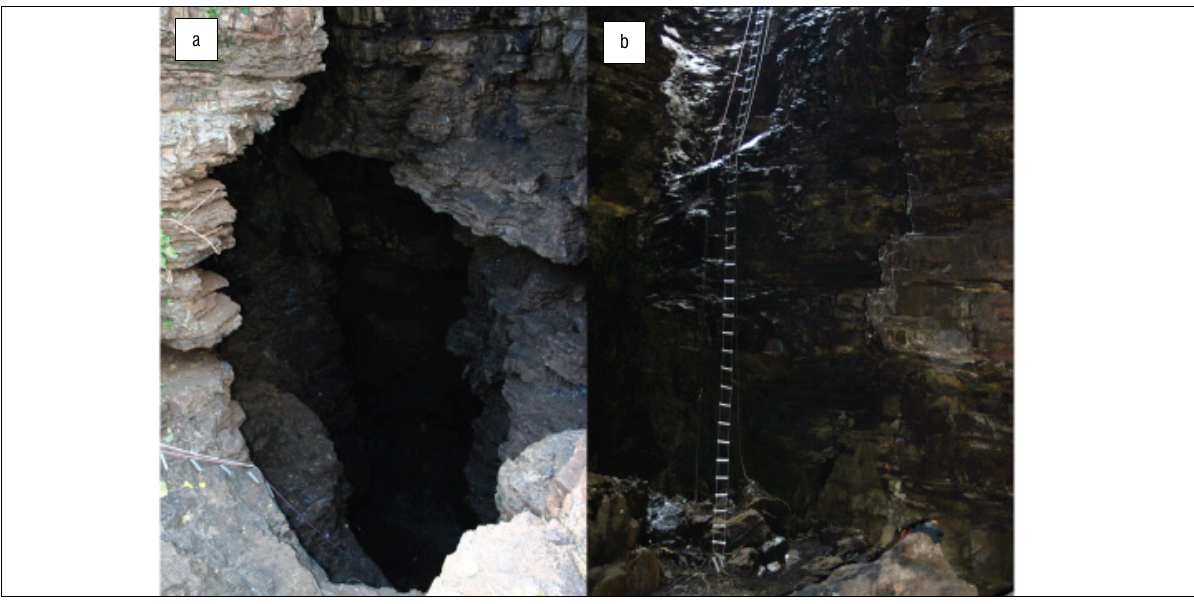
Photographs: Jason L. Heaton, reproduced with permission. Figure 3: